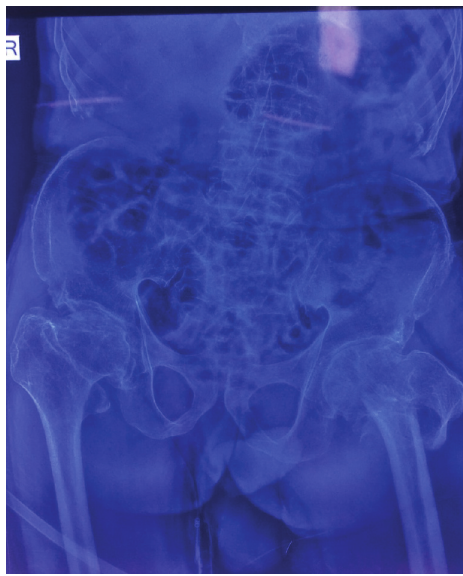
Figure 1: Intertrochanteric fracture of the femur (left).